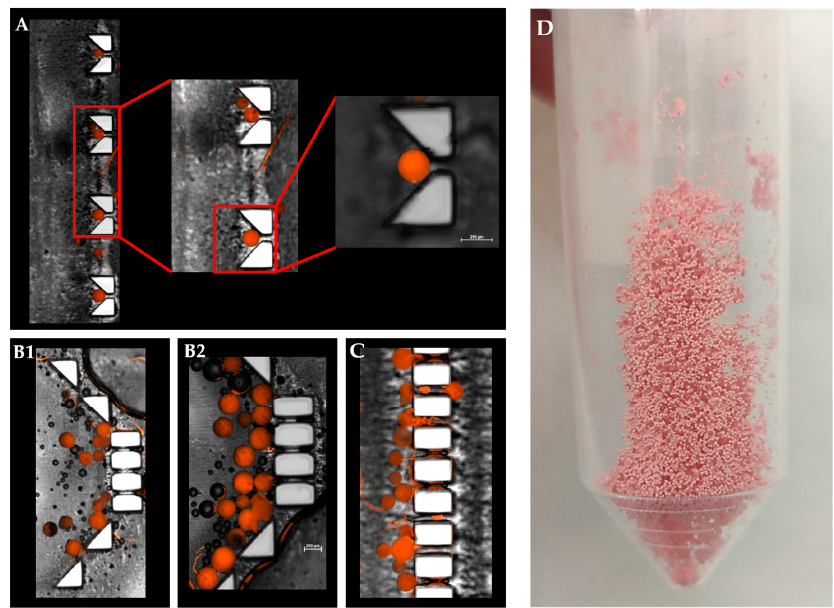
Figure 6. Combined fluorescence and bright-filed microscopy image of a “V” and “basket” shape mechanical barrier. ( A ) . Magnified view of a single polymeric microsphere captured in a ‘V’ trap design. ( B1 , B2 ) . DOX-PMS captured in the “basket” trap design. ( C ) . Trapped DOX-PMS in final pillar barriers before the outlet tube. ( D ) Lyophilized microfluidic based